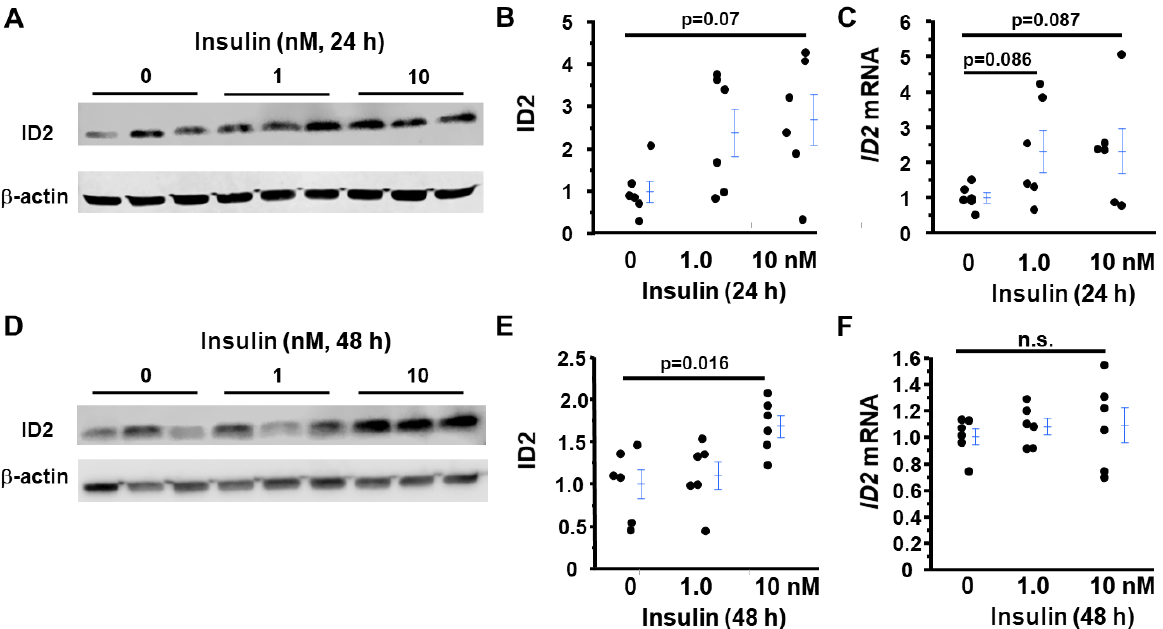
Figure 6. Insulin induces ID2 expression in human trophoblasts . After starving with 0% FBS me- dium for 18 h, human first-trimester trophoblasts (HTR8/SVneo) were exposed to 0, 1, and 10 nM insulin for 24 h ( A – C ) or 48 h ( D – F ). (A and D). Western blot and ( B and E ) densitometric quantita- tion of ID2; n = 6. ( C and F ) mRNA of ID2 in cells treated with different doses of insulin; n = 6. n.s.: not